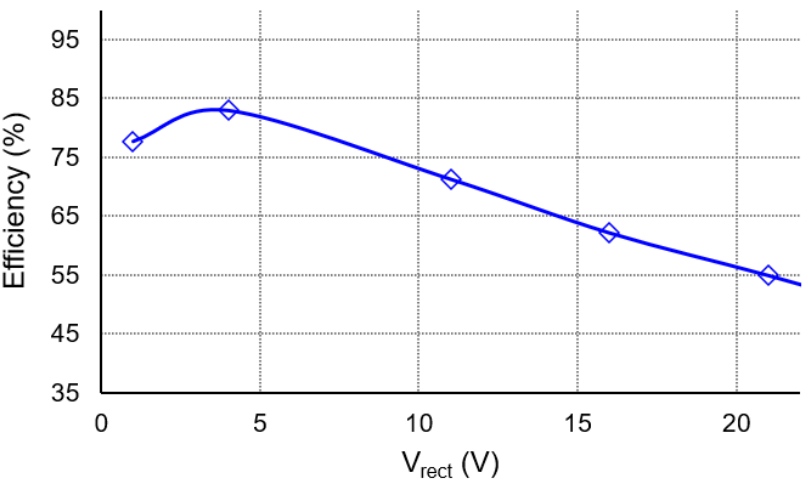
Figure 16. Power conversion efficiency of the circuit.